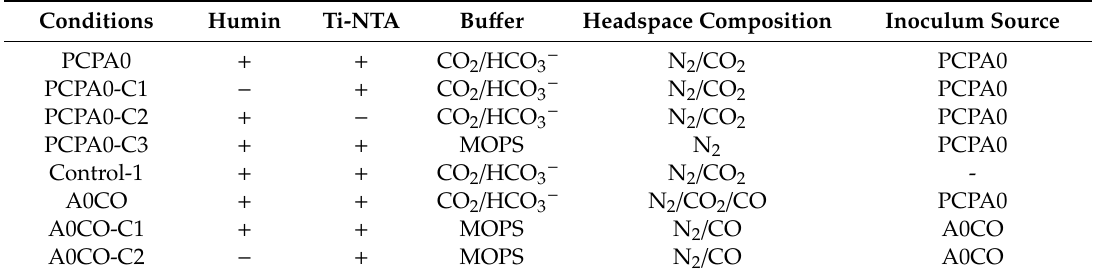
Table 1. Experimental setup in this study. The notation “ + ” and “ − ” indicates the presence and absence of the respective